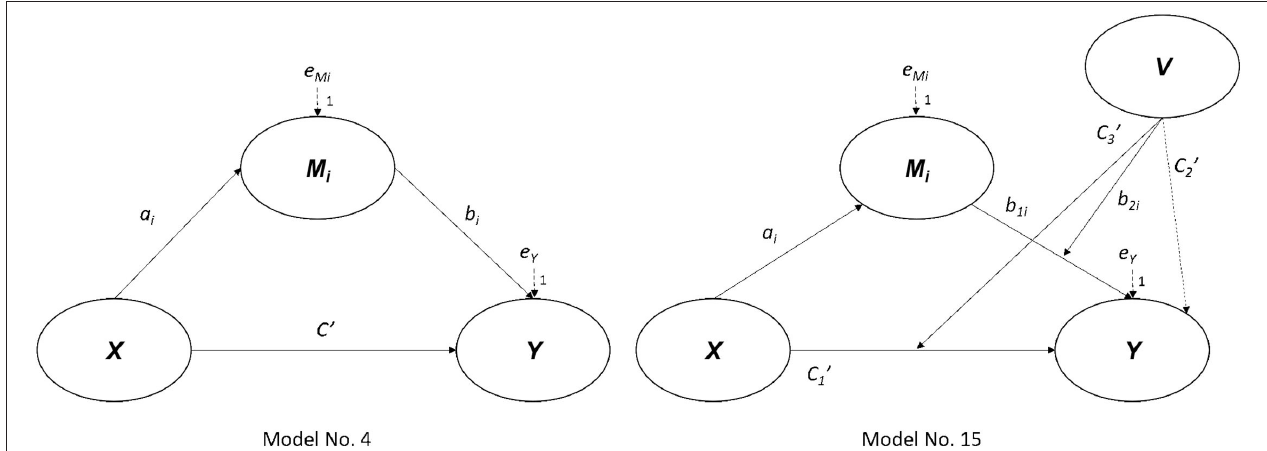
FIGURE 3 | The applied regression analysis model. Source: Referred from Hayes